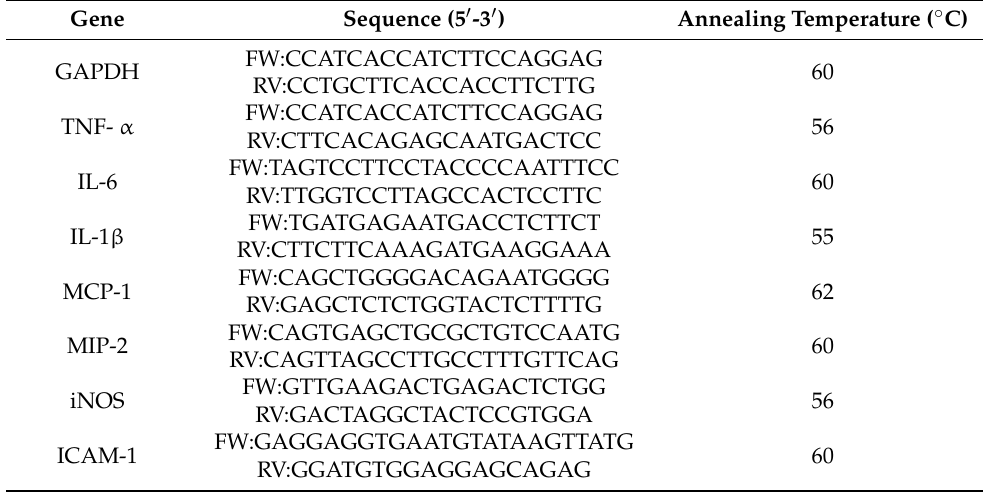
Table 1. Primer sequences and annealing temperatures used in real-time PCR assays in colonic tissue.